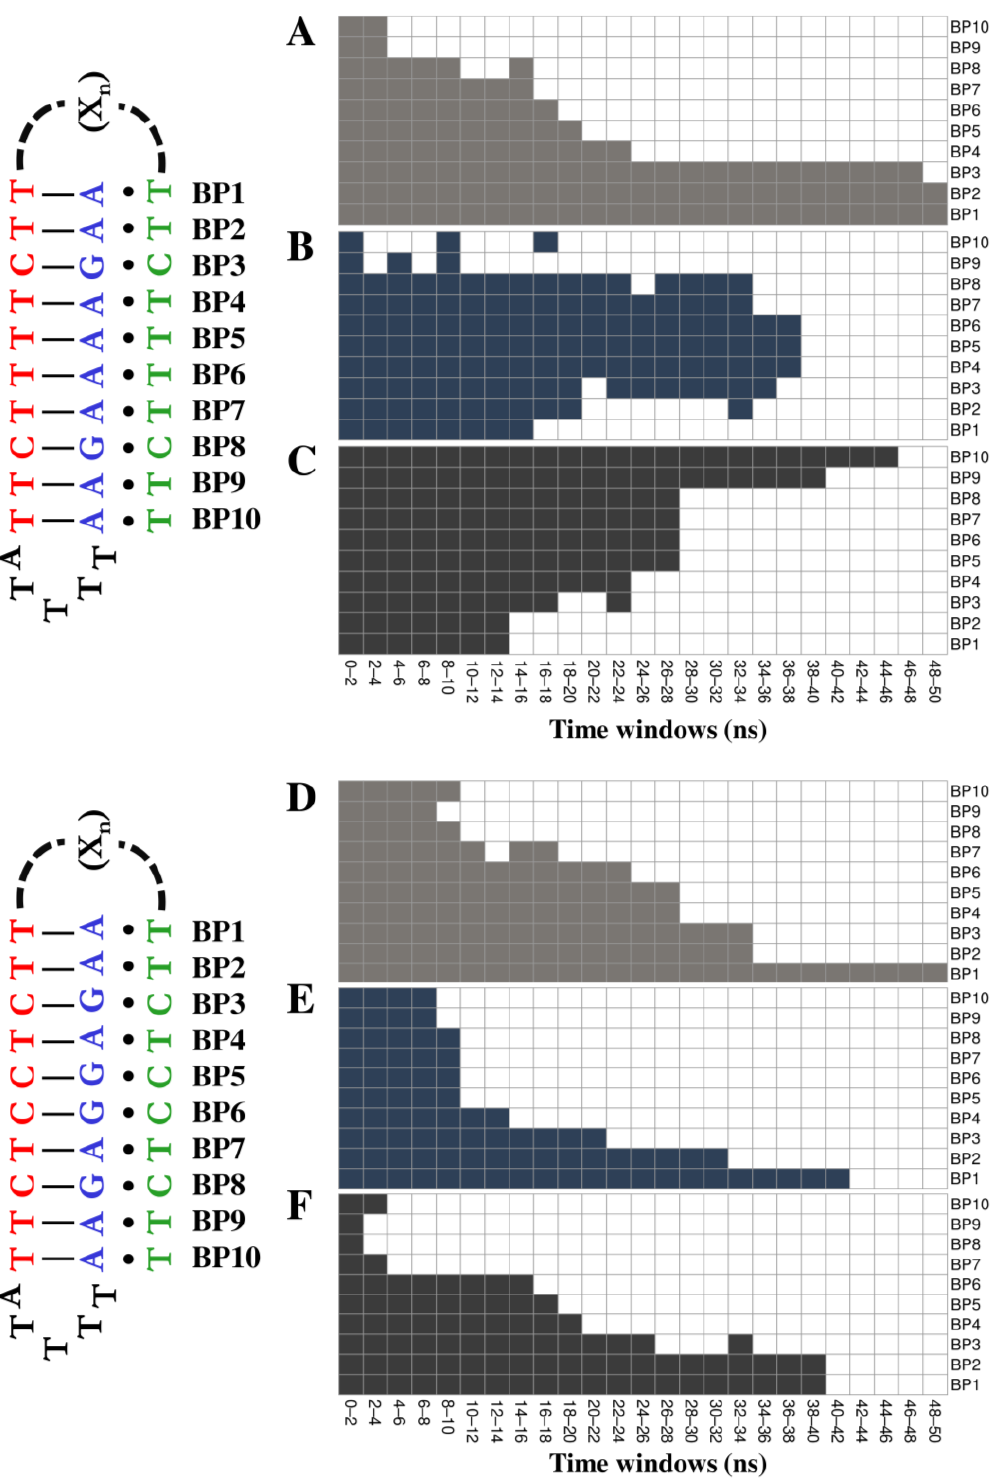
Figure 4. Per-base unbinding profile of TFO from the DH as a function of time. For each 2-ns time window, the distance between the centers of mass of the TFO and of the DH C2 (cid:48) atoms was calculated, and the corresponding rectangle in the plot was colored if the average distance was lower than 3.2 Å. A white rectangle indicates the loss of the interaction. The profile is reported for the DIPRO5 ( A ), DIPRO15 ( B ), DIPRO25 ( C ), TETRA5 ( D ), TETRA15 ( E ) and TETRA25 ( F ) switches.